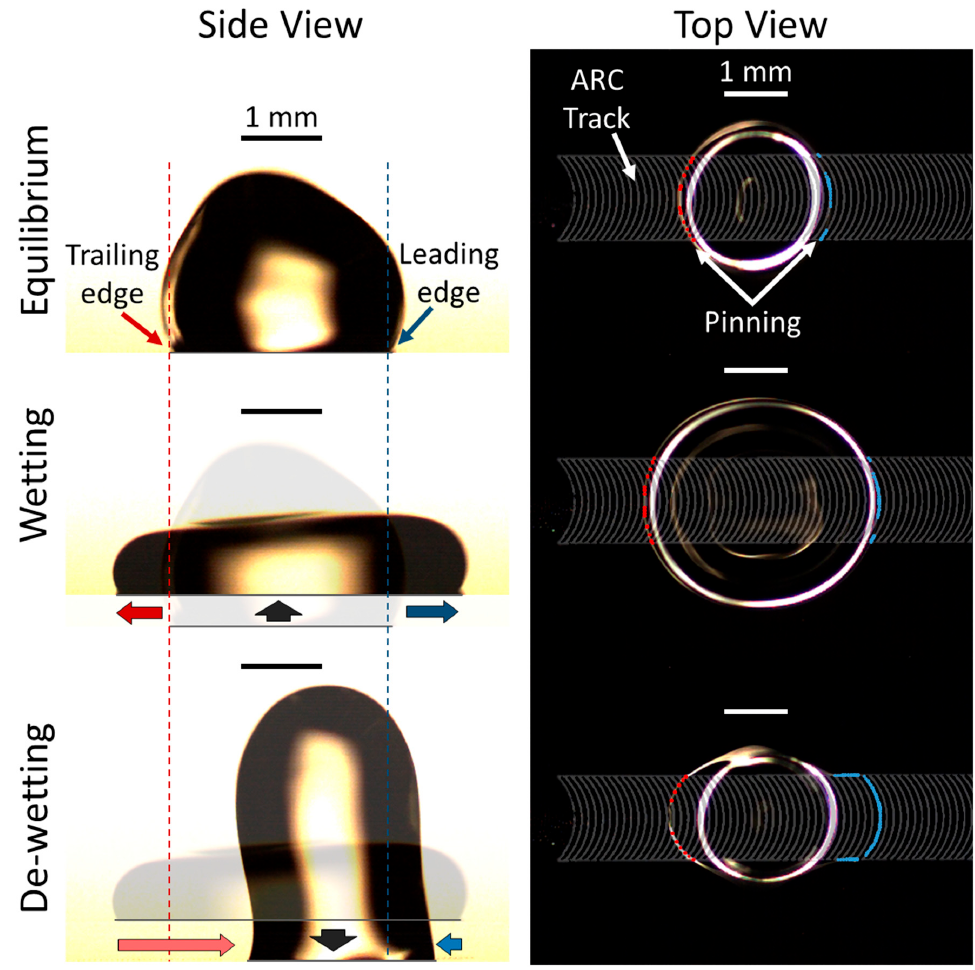
Figure 1. Mechanisms of droplet transport on anisotropic ratchet conveyors (ARCs). Droplets are transported by an ARC pattern ( top view ) that is composed of periodically spaced, curved rungs. The shape of the rungs creates a difference in pinning forces between the leading and trailing edges of the droplet, as only the front edge of the droplet can conform with the rung curvature. Vibration (vertical movement of the substrate) causes the edges of the droplet to oscillate between wetting and de-wetting phases. The increased pinning on the leading edge of the droplet creates an asymmetric force during the de-wetting phase, which results in a net force in the direction of droplet transport over a complete vibration cycle ( side view ). On the side view, the blue dashed line and arrows indicate the initial position and movement of the leading edge, and the red dashed line and arrows indicate the initial position and movement of the trailing edge, respectively. On the top view, blue and red dots indicate regions of the leading and trailing edges, respectively, that are pinned to the hydrophilic ARC pattern. Scale bars (black on side view and white on top view) indicate 1 mm. A sinusoidal vibration, applied vertically, causes the edges of the droplet to oscillate between wetting (edges of the droplet are advancing away from the centroid) and de-wetting (edges are contracting toward the centroid) phases. This combination of edge oscillation and a difference in pinning forces between leading and trailing edges results in a net force that drives droplet transport [14,18,19]. Previous work demonstrated a first principles model that showed droplet transport was enabled by two key anisotropies on ARCs: (1) pinning forces are greater on the leading edge of the droplet, and (2) the droplet is less susceptible to the ARC pattern during wetting (i.e., the difference in contact angle between the leading and trailing edges is larger during de-wetting than wetting) [22].